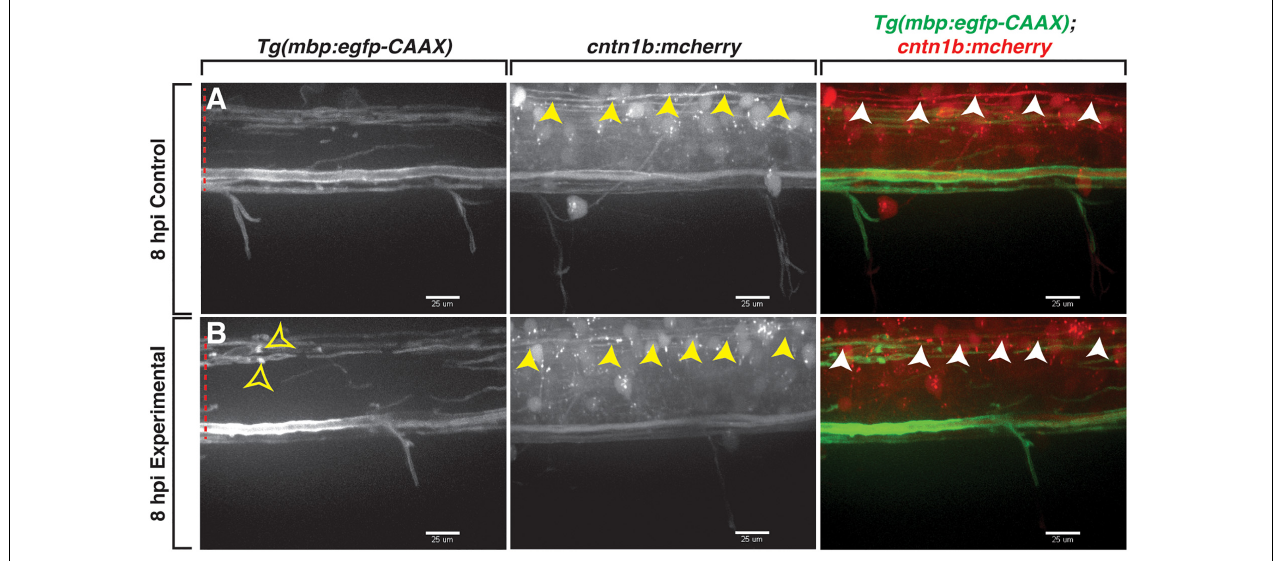
FIGURE 4 | Axons are indistinguishable between control and lysolecithin-injected larvae. All images are lateral views of the spinal cord with anterior to the left and dorsal to the top. (A,B) mCherry + axons (arrowheads) within the control (A) and lysolecithin (experimental) (B) dispersal regions are indistinguishable at 8 hpi. mbp + ovoids are denoted with open arrowheads. Red dashed lines denote the spinal cord. Scale bars, 25 µ